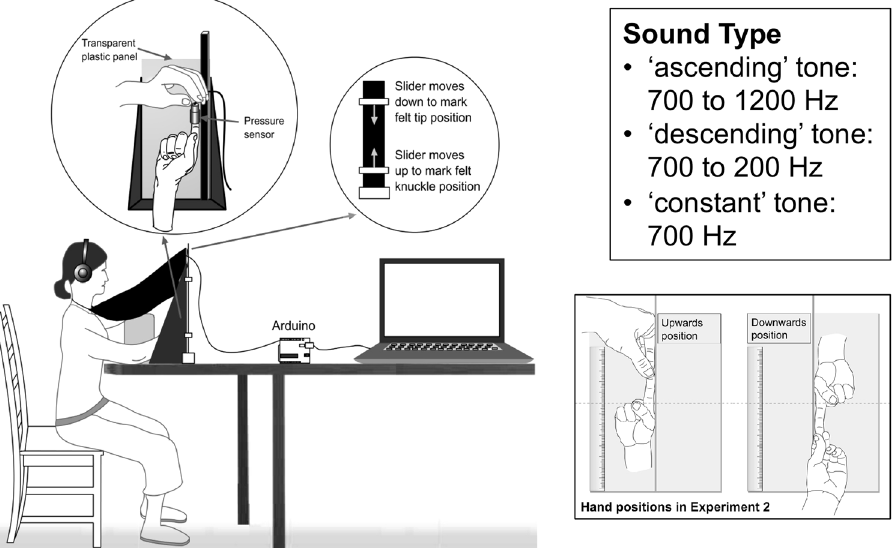
Figure 1. Experimental setup and design: A black cloak was used to hide the hand from the participant’s view. Participants were asked to hold their index finger still and straight. On each trial, the pulling of the finger was detected by a pressure sensor and simultaneously triggered a 2000-ms pure tone (‘ascending’, ‘descending’ or ‘constant’ in Experiment 1, ‘ascending’ or ‘descending’ in Experiment 2) that participants listened to through headphones. After the sound ended, the task was to estimate the position of the fingertip and knuckle using the apparatus shown in the right circle. In Experiment 1 participants kept their index fingertip pointing upwards during all the experiment, which included 10 repetitions of each sound type. In Experiment 2 the position of the hand was varied between two experimental blocks (each block with 10 repetitions of each sound type), so that participants either kept the fingertip pointing upwards or downwards, as shown in the figure (note that the ruler is displayed for illustration purposes, but that it was blacked out on the side facing the